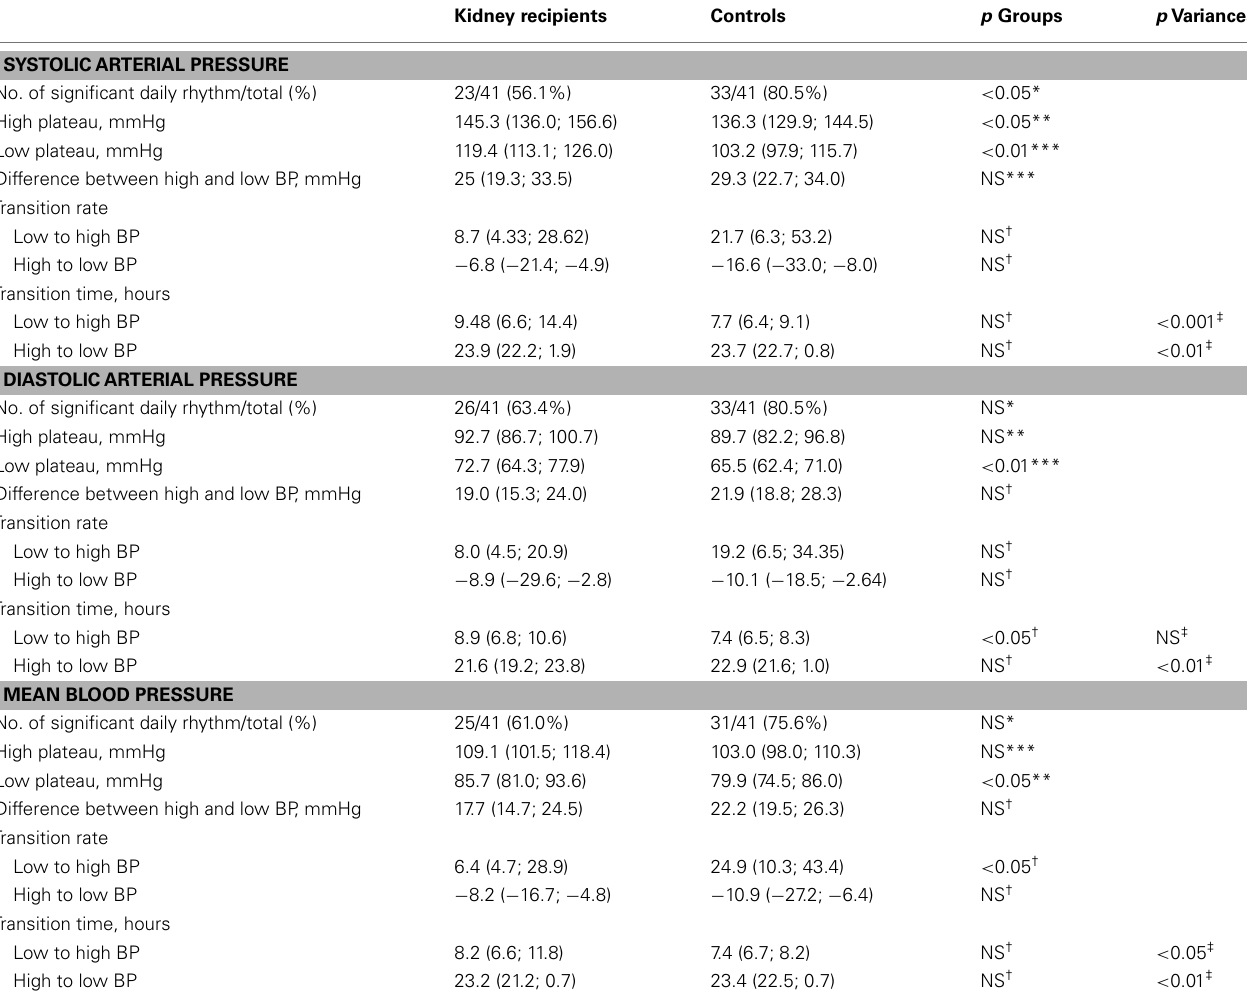
Table 2 | Comparison of parameters analyzed by double-logistic method between renal transplant recipients and controls. Kidney recipients